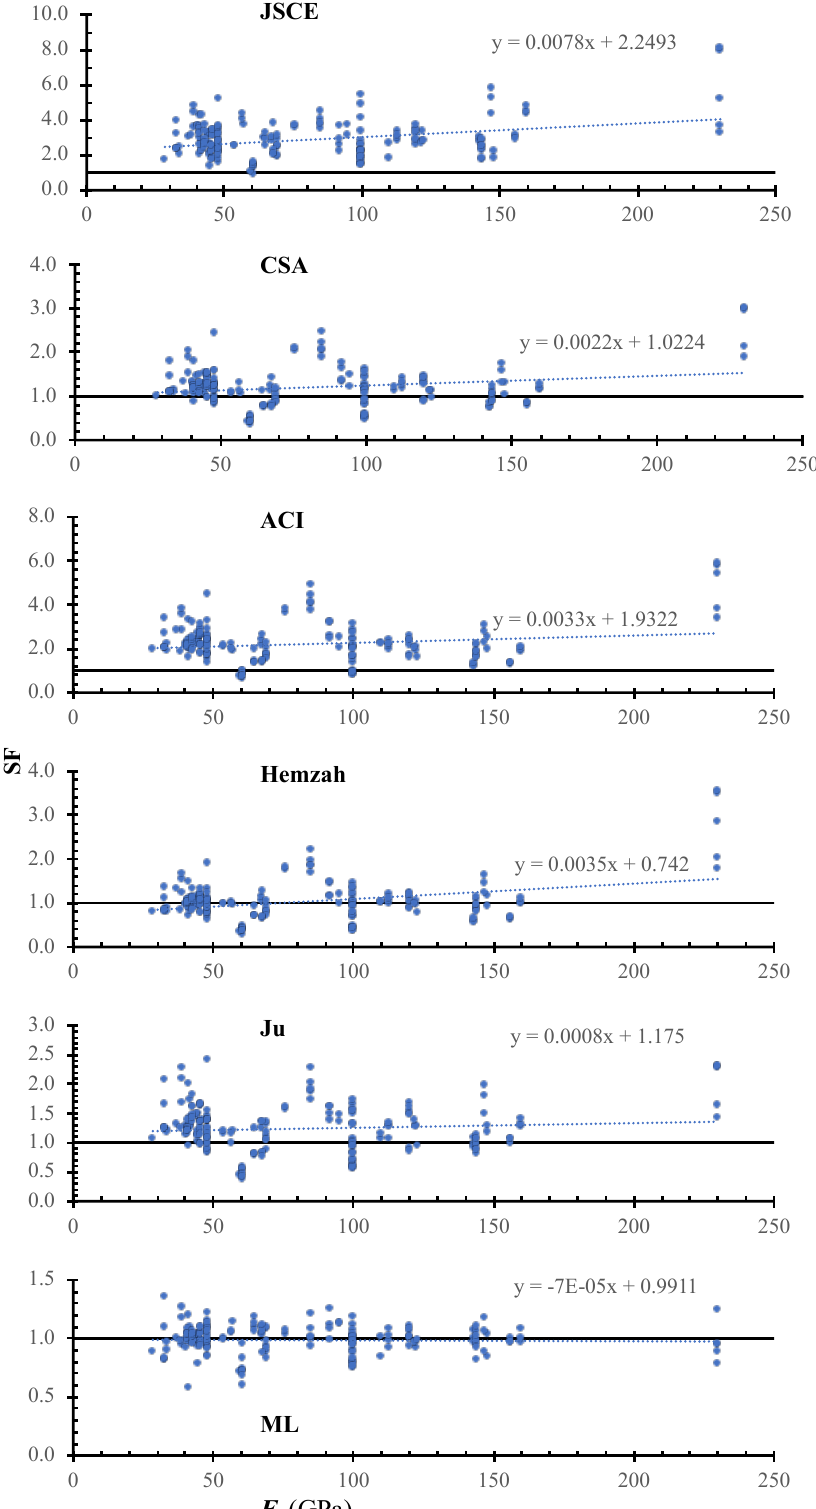
Figure 8. SF calculated using various models versus Γ